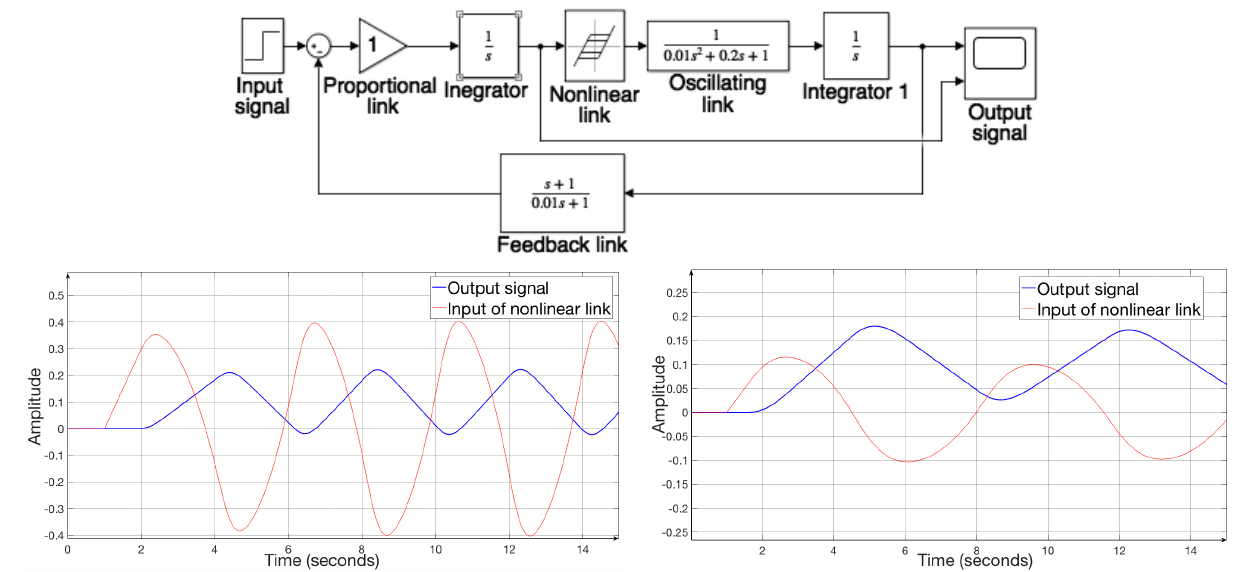
Figure 14. Scheme of an unstable nonlinear ACS and processes at different gain factors K1,2.